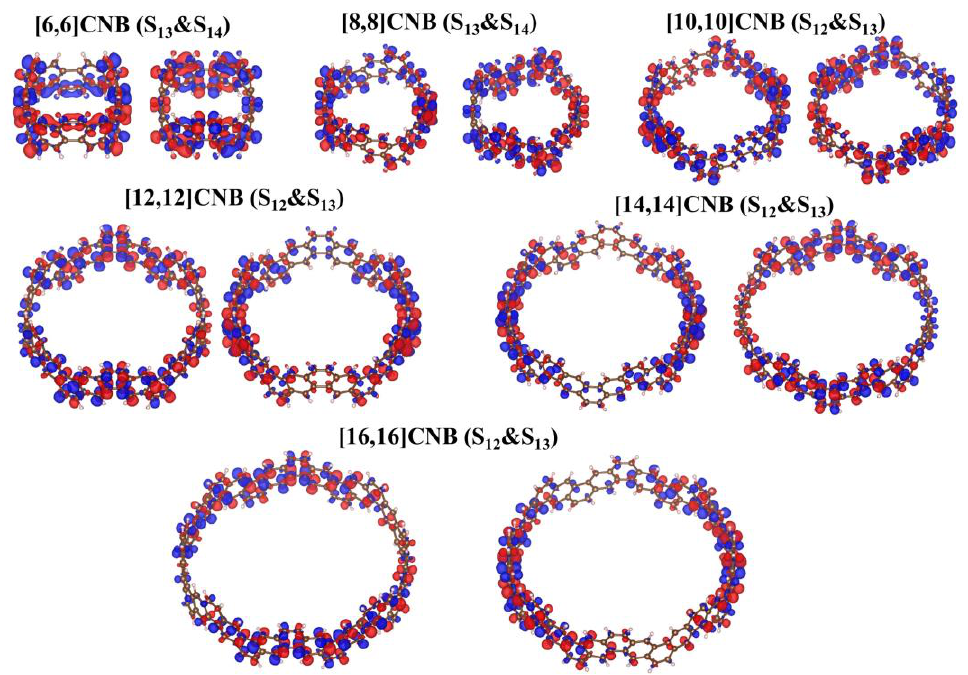
Figure 5. Transition dipole moment density of the strongest absorption peaks of [2N,2N]CNB. Red and blue represent the regions where the transition dipole moment is positive and negative, respec- tively.